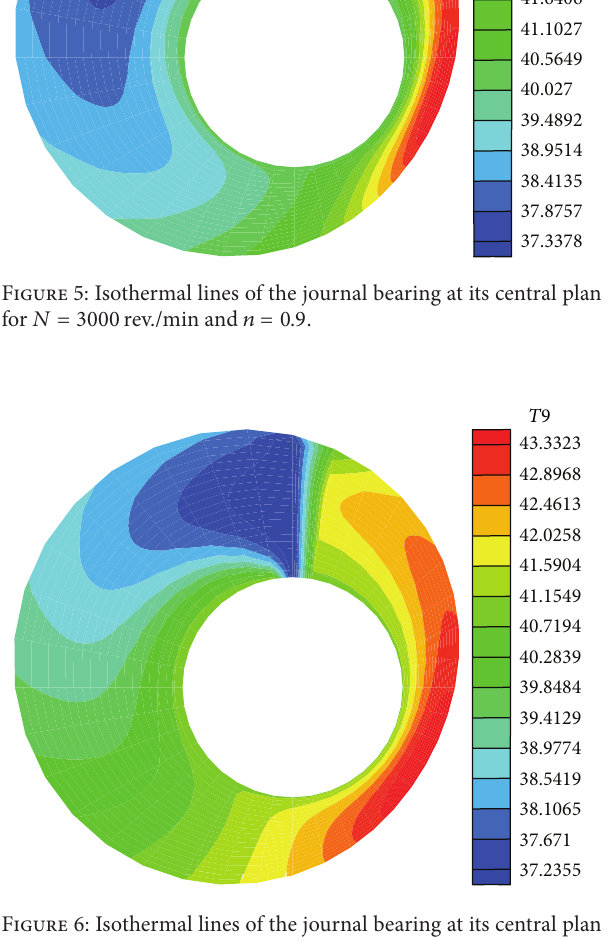
Figure 6: Isothermal lines of the journal bearing at its central plan for 𝑁 = 1000 rev./min and 𝑛 = 1